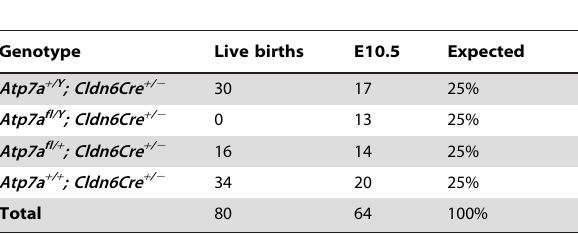
The numbers of live-born offspring or embryos at day 10.5 post coitus (E10.5) are shown for each genotype resulting from a cross between Atp7a fl/ + females